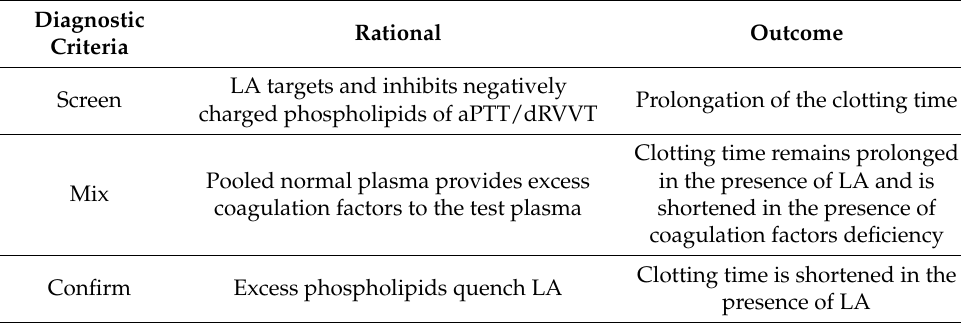
Table 1. Diagnostic criteria to detect lupus anticoagulant